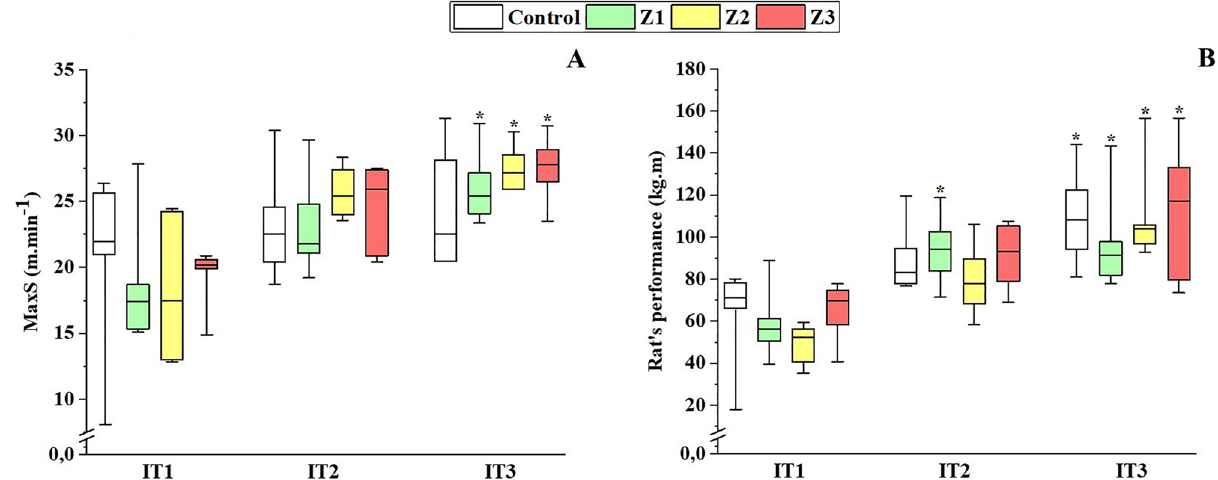
Figure 3. Effect of four weeks of running training on the maximal speed (MaxS) achieved in the incremental test (IT) ( A ) and rats’ performance quantified ( B ). Z1 = low intensity training group; Z2 = moderate intensity training group; Z3 = high intensity training group; IT = incremental test; * = statistically significant difference compared to IT1.